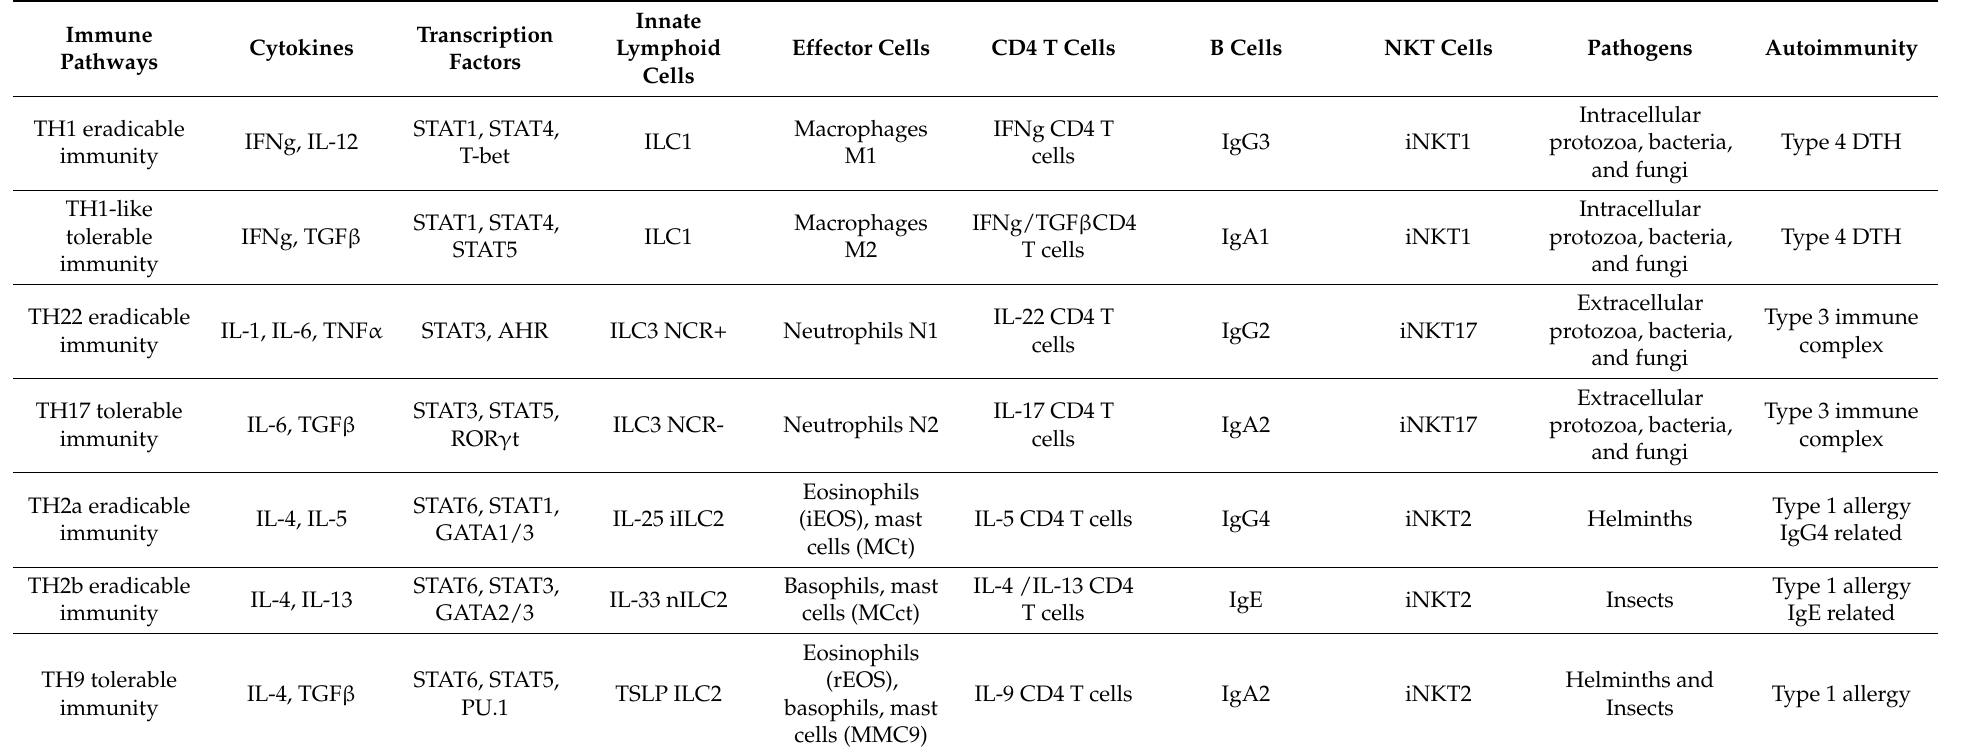
Table 1. Summary of host immunological pathways against